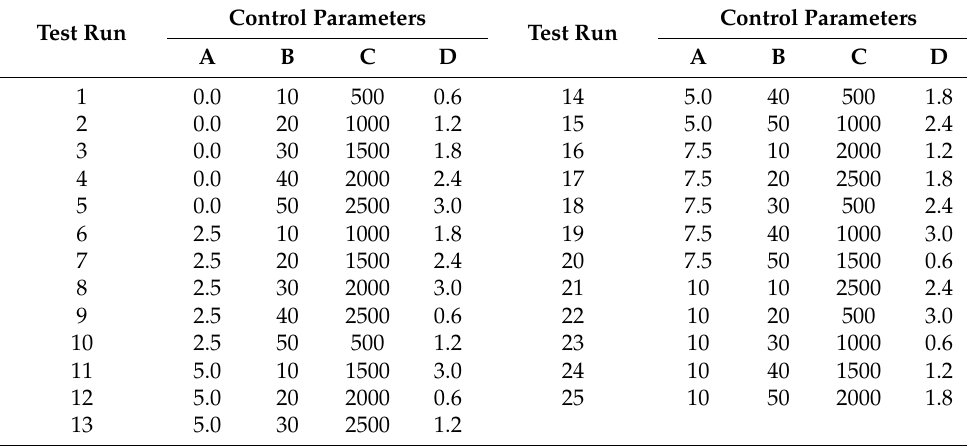
Table 2. Experimental